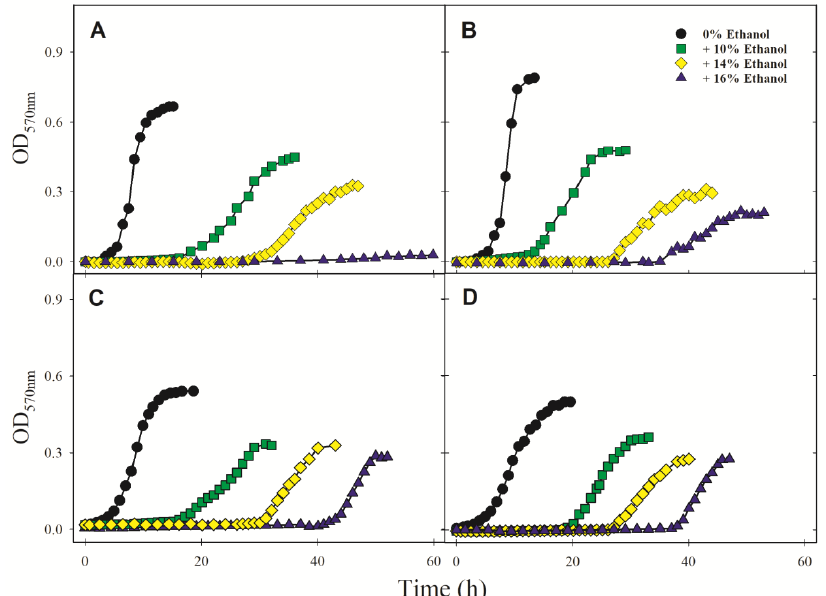
Figure 1. Ethanol tolerance of the industrial fuel ethanol strain CAT-1 ( A ) and the recombinant strains CAT1-TRP1oe ( B ), CAT1-MSN2oe ( C ), and CAT1-N ∆ MSN2oe ( D ), determined by the capacity to grow in liquid YP-20 g/L sucrose media in the presence of the indicated concentrations of ethanol.